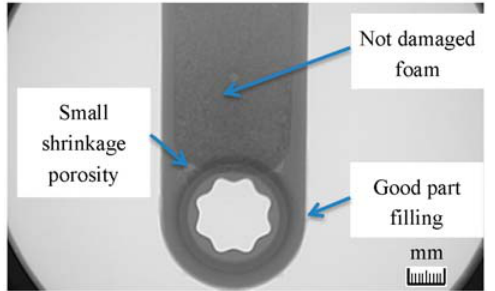
Figure 19. Injected HPDC with core foam at standard parameters.